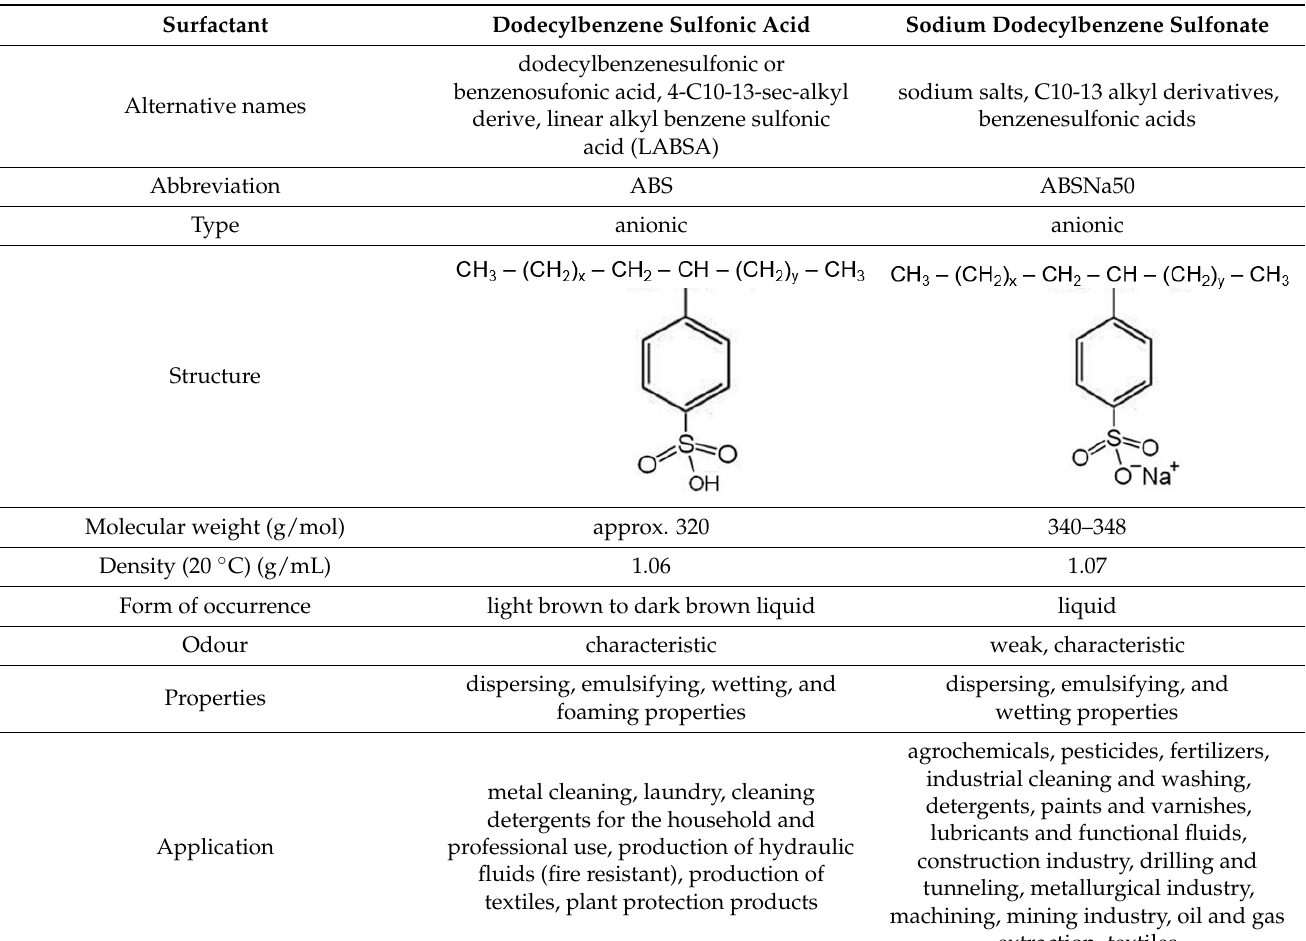
Table 1. Characterization of anionic surfactants, based on the information from the manufacturer’s brochures.